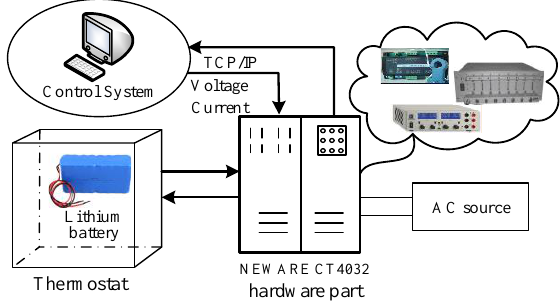
Figure 5. Discharge testing system schematic diagram.